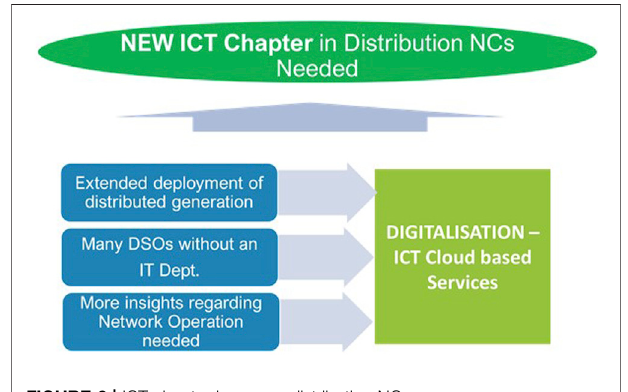
FIGURE 2 | ICT chapter in energy distribution